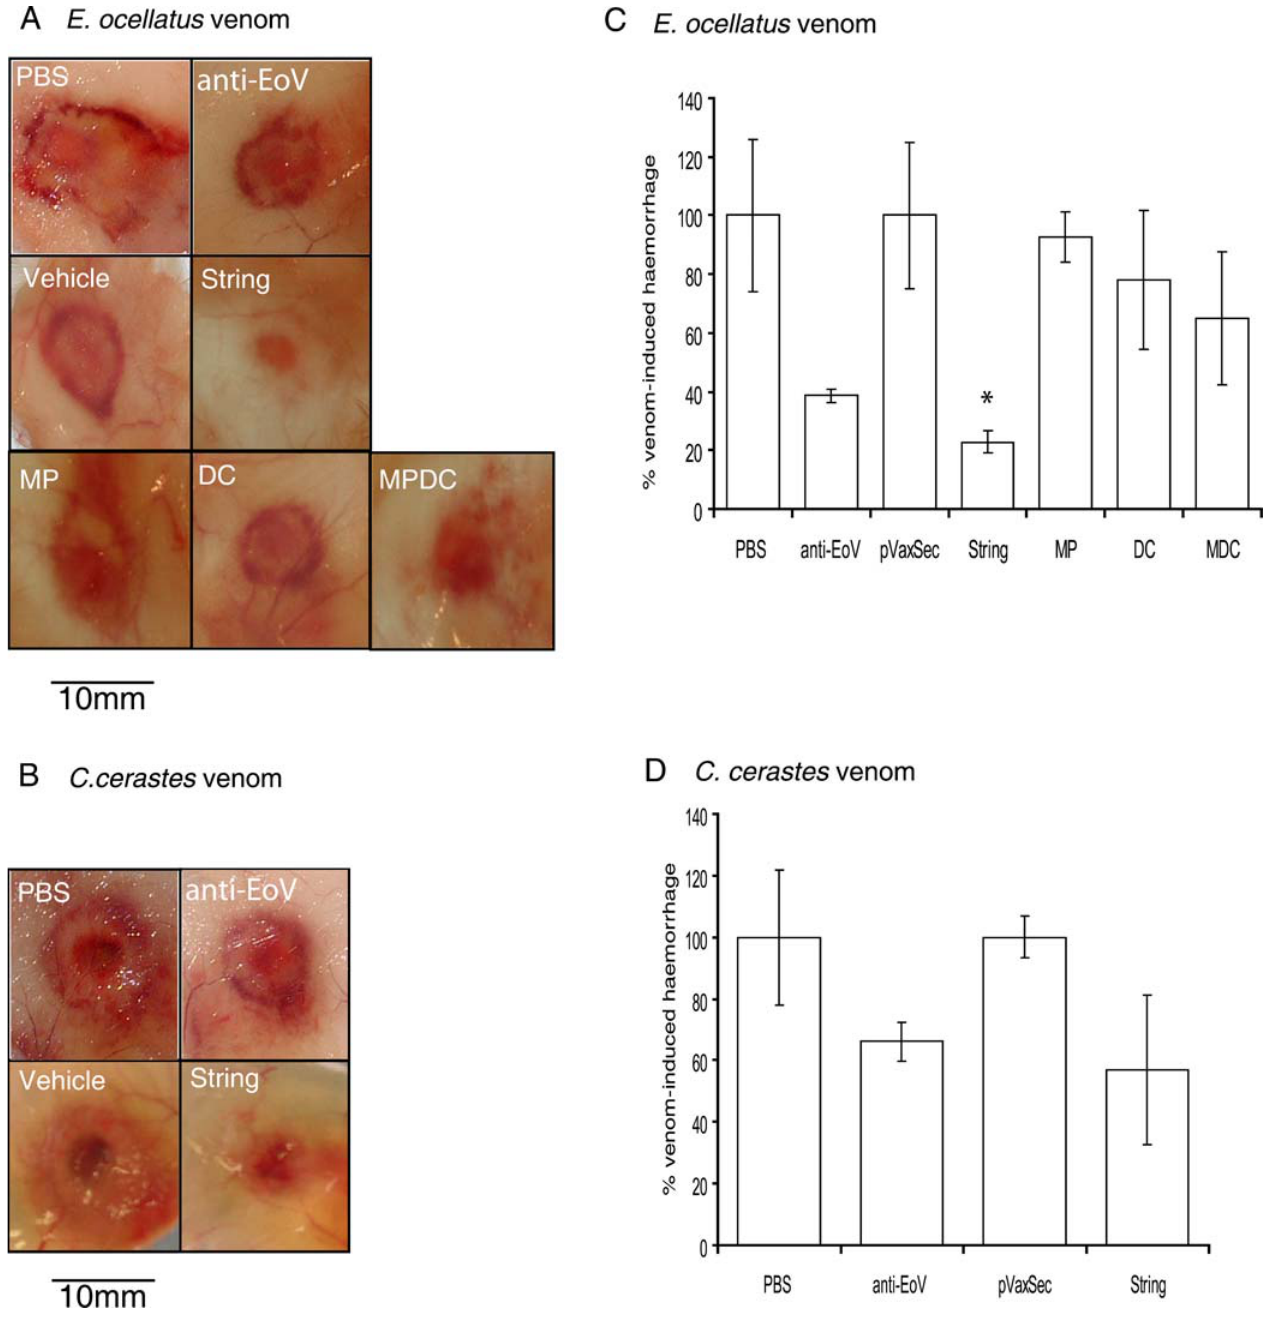
Figure 6. Neutralization of Venom-Induced Hemorrhage (A and B) Representative hemorrhagic lesions in the skin of mice injected with one minimum hemorrhagic dose of E. ocellatus venom (A) and C. cerastes venom (B) following preincubation with PBS, rabbit anti- E. ocellatus venom (anti-EoV), or pooled sera from mice immunized with the indicated DNA immunogens. (C and D) The above data expressed as mean standardized area of hemorrhage on the inner surface of the skin ( 6 1 standard error of the mean). Values are expressed mean percentage hemorrhage relative to control, pVaxSec (DNA immunogens), or PBS (protein immunogens) which was taken as 100%. A result statistically significant relative to controls is denoted by an asterisk. DOI: 10.1371/journal.pmed.0030184.g006